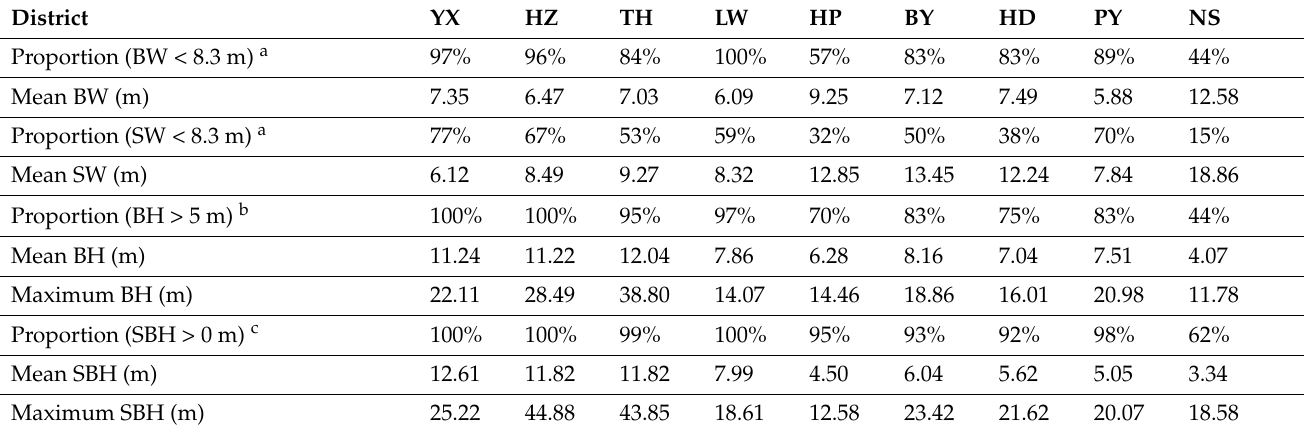
Table 3. Statistics regarding the urban morphology (UM) in different